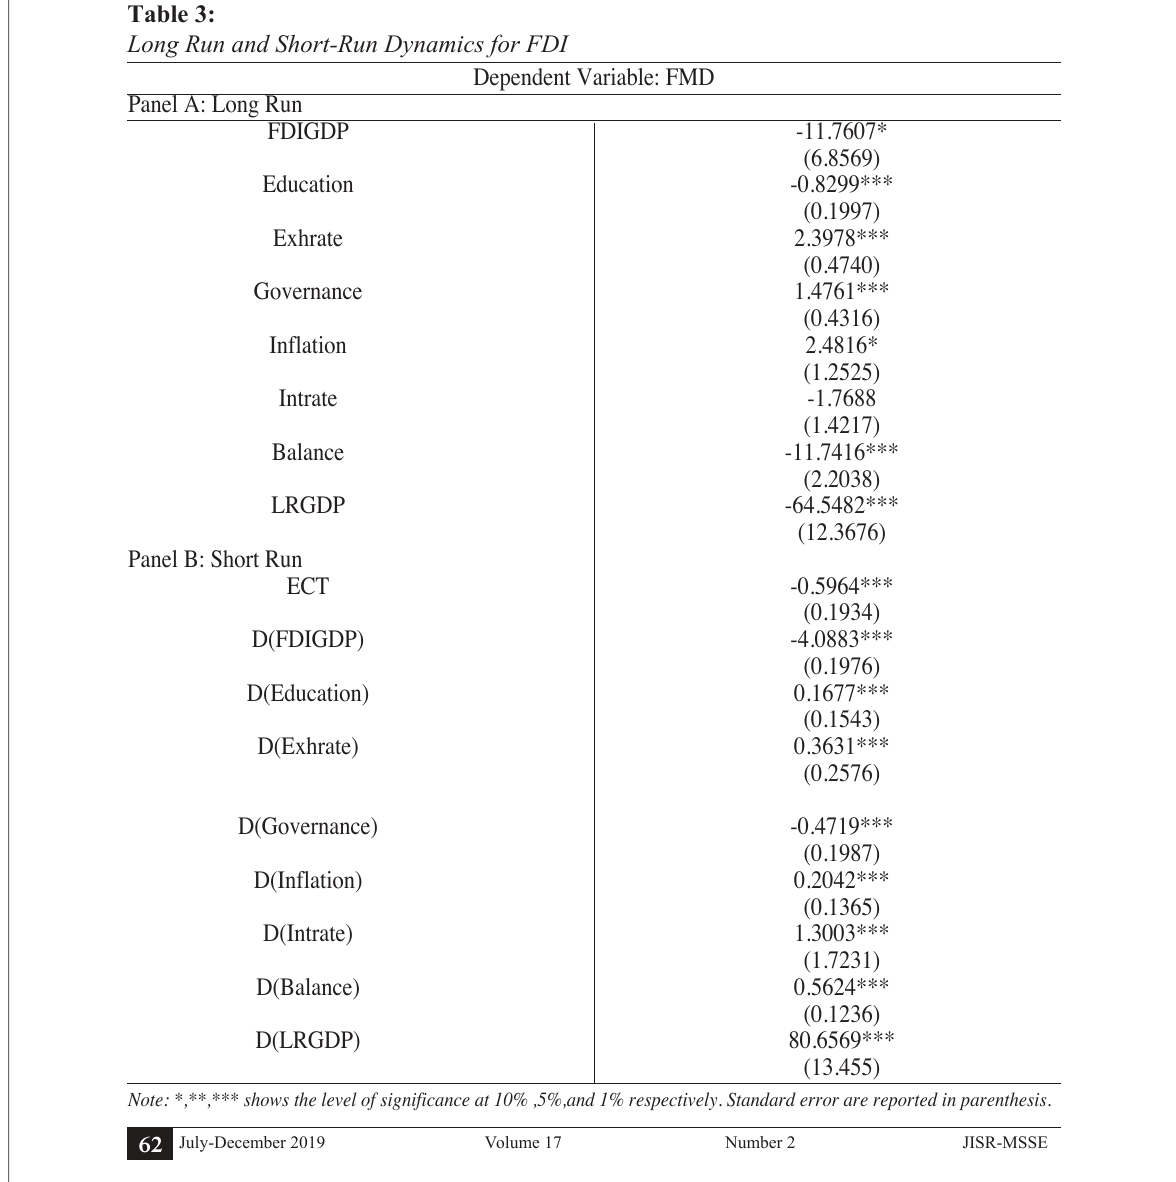
Dependent Variable: